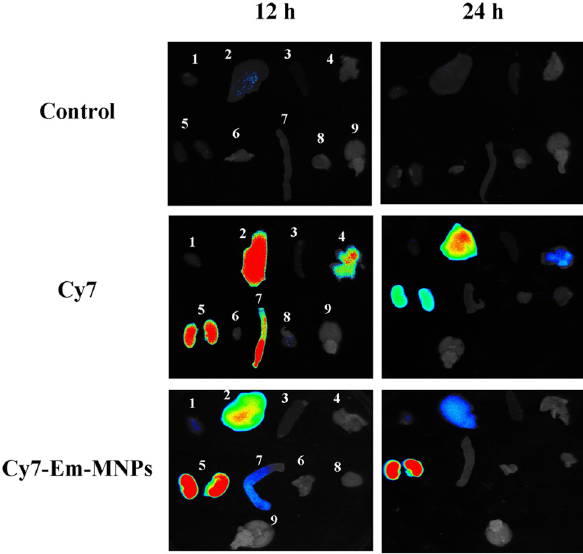
Figure 8: Ex vivo fl uorescence imaging. Balb/c mice injected with PBS ( control ) , and Cy7 and Cy7 - Em - MNPs for 12 h and 24 h, respectively and major organs were collected for imaging. 1, heart; 2, liver; 3, spleen; 4, lung; 5, kidney; 6, thymus; 7, small intestine; 8, muscle; 9,